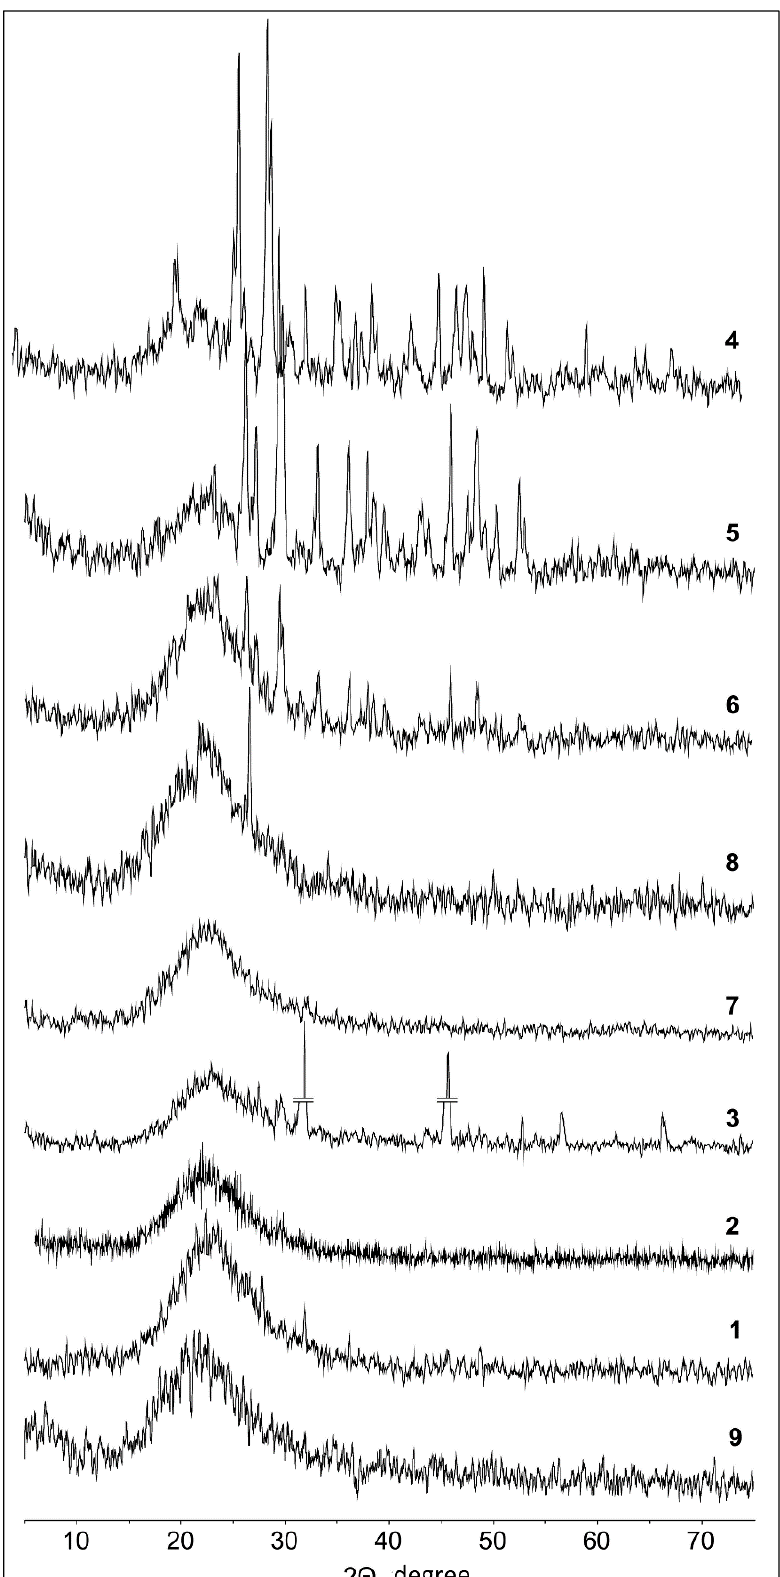
Figure 11. X-ray diffractograms of the studied samples (numbers according to Table 1).